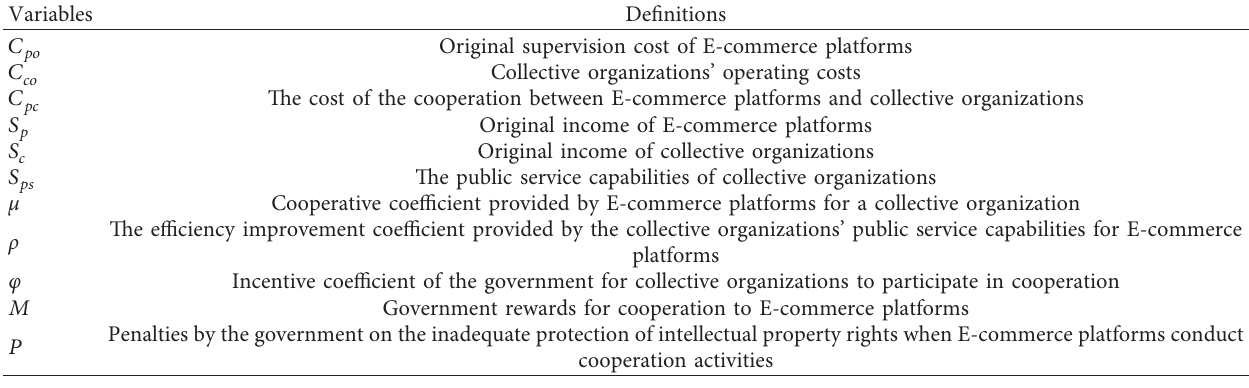
Table 1: The relevant variables.